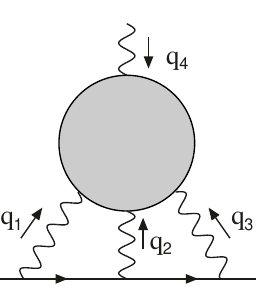
Figure 1 . The HLbL contribution to a µ . The grey blob contains hadronic contributions. The photon with momentum q is the external magnetic field. The bottom line is the muon and the 4 wiggly lines are